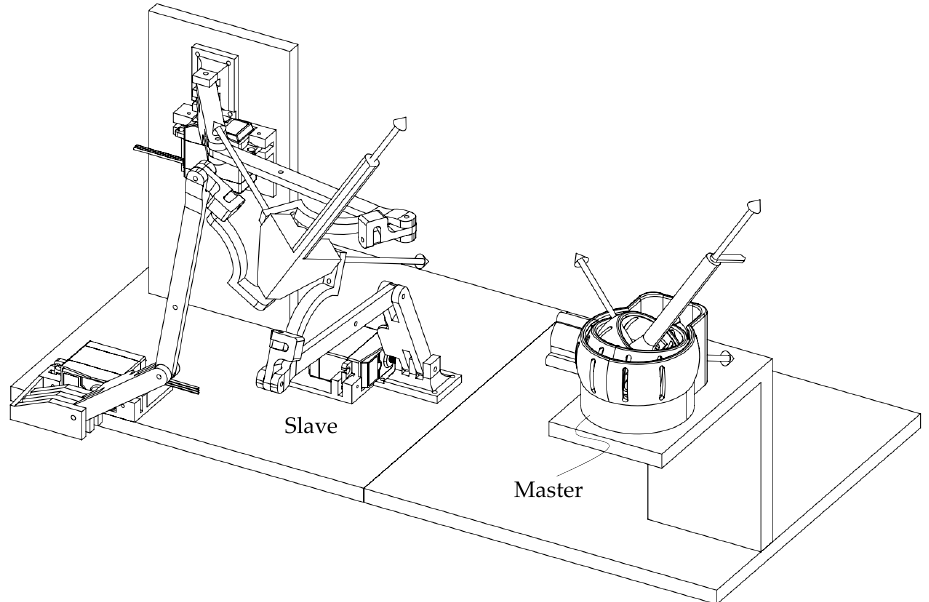
Figure 14. Mechanism configuration at t = 38.5